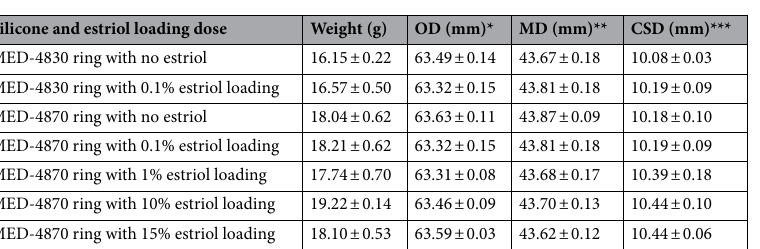
Table 1. Morphological dimensions and weight of silicone pessary rings. *Outer diameter (OD), **Membrane diameter (MD), ***Cross-sectional diameter (CSD).